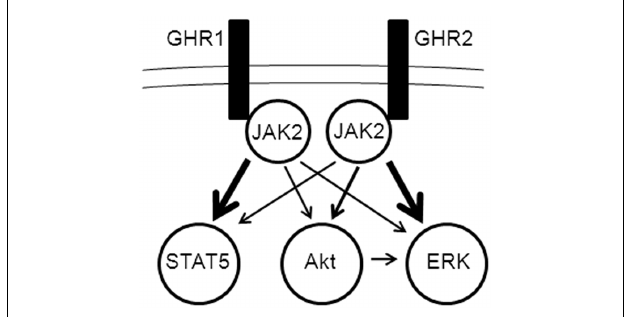
FIGURE 4 | Model of differential activation of signaling pathways by growth hormone receptor (GHR) subtypes. JAK2 activation is essential for propagation of signaling from both GHR1 and GHR2 to the ERK, PI3K/Akt, and STAT5 pathways (details of pathway elements are omitted for simplicity). Cross-talk occurs between the ERK and PI3K/Akt pathways, possibly through Akt activation of c-Raf in the ERK